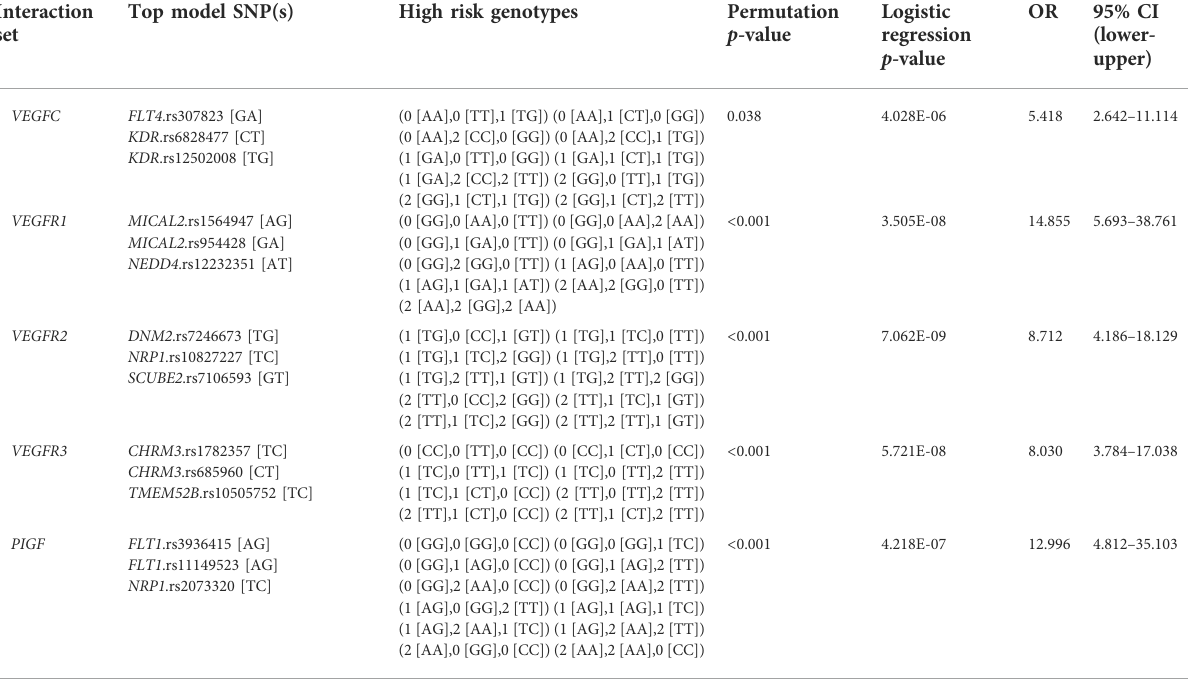
TABLE 4 ( Continued ) Multivariable logistic regression analysis results for the top GMDR 0.9 models in the VEGF interaction network set analyses (disease-speci fi c survival).